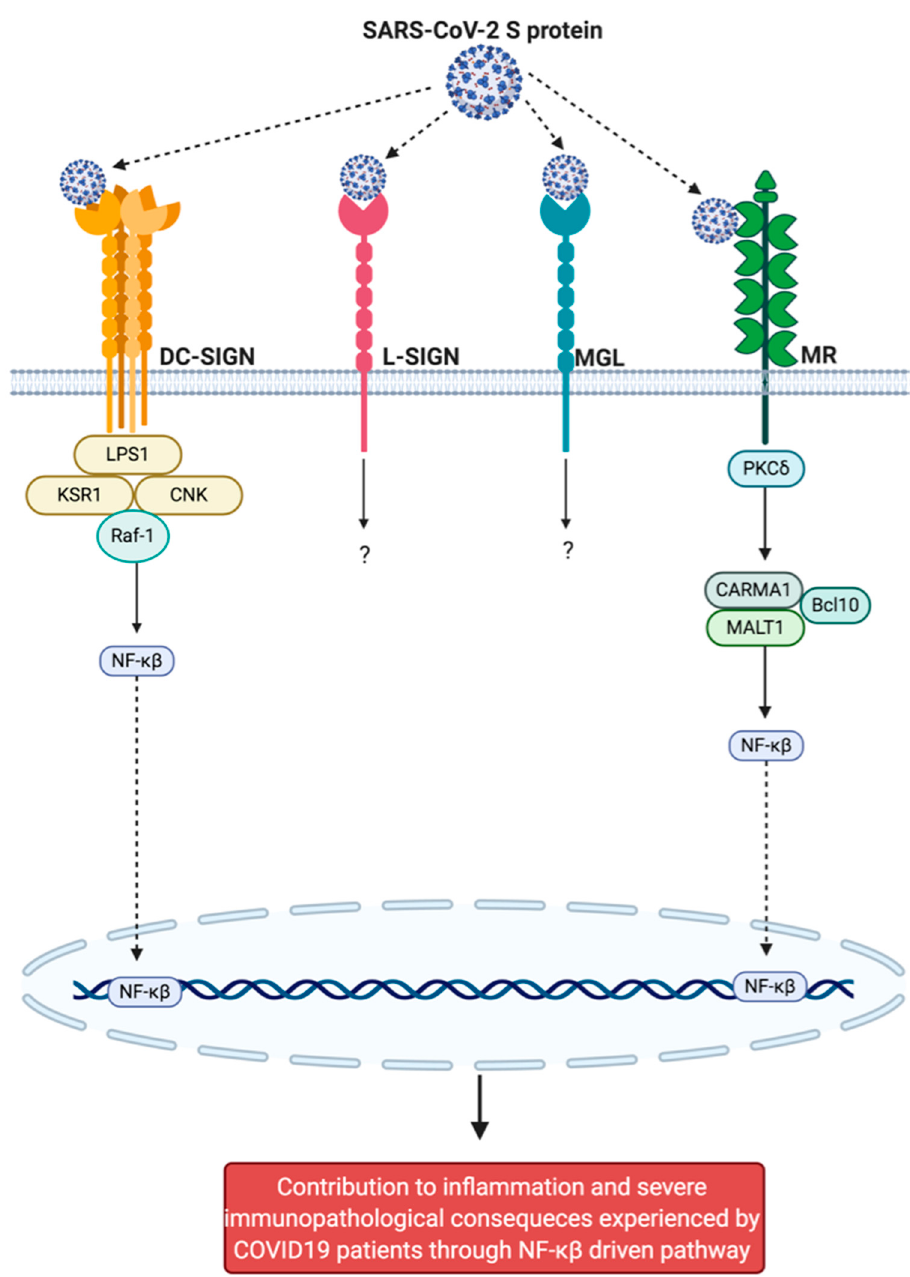
Figure 5. Postulated pathways involving specific C-lectin type receptors (CLR) that have been shown to bind to SARS-CoV-2 spike protein. DC-SIGN, L-SIGN, MGL, and MR have been shown to directly associate with carbohydrate motifs present on the outer surface of SARS-CoV-2 S protein [35]. The signal transduction of L-SIGN and MGL remains undetermined. However, we postulate that DC-SIGN and MR may contribute to inflammation and severe immunopathological manifestations experienced in COVID-19 patients through NF-kB pathway, which has previously been reported in fungal infections [260]. Abbreviations: B-cell lymphoma/leukemia 10, Bcl10; caspase recruitment domain-containing membrane- associated guanylate kinase protein-1, CARMA1; connector enhancer of kinase suppressor of Ras1, CNK; kinase suppressor of Ras1, KSR1; lymphocyte-specific protein kinase-1, LSP1; mucosa-associated lymphoid tissue lymphoma translocation protein 1, MALT1; protein kinase C delta, PCK 𝛿 ; proto-oncogene, serine/threonine kinase, Raf-1.